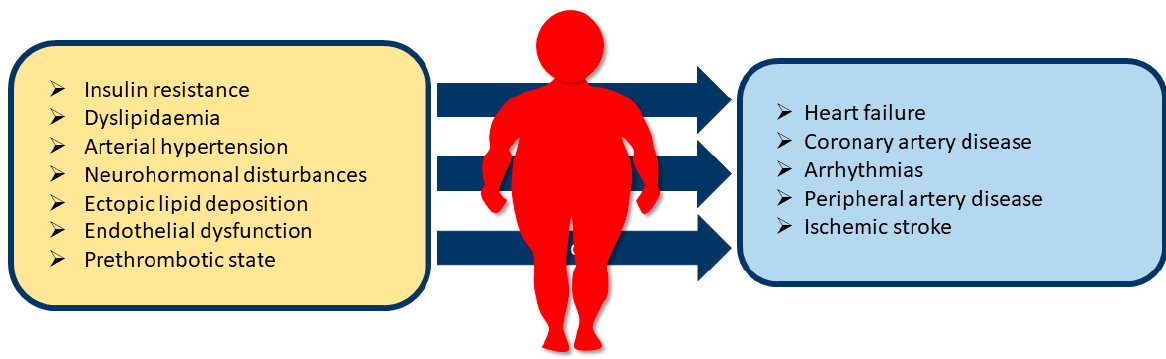
Figure 1. Relationship between obesity-related cardiometabolic alterations/comorbidities and cardiovascular diseases.